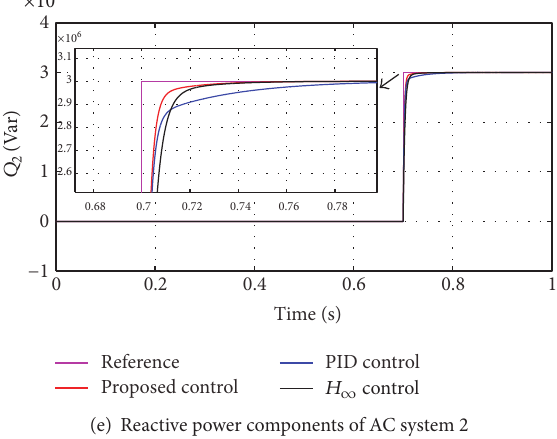
system 2. At 𝑡 = 0.3 s, 𝑄 1 is changed as a step response to